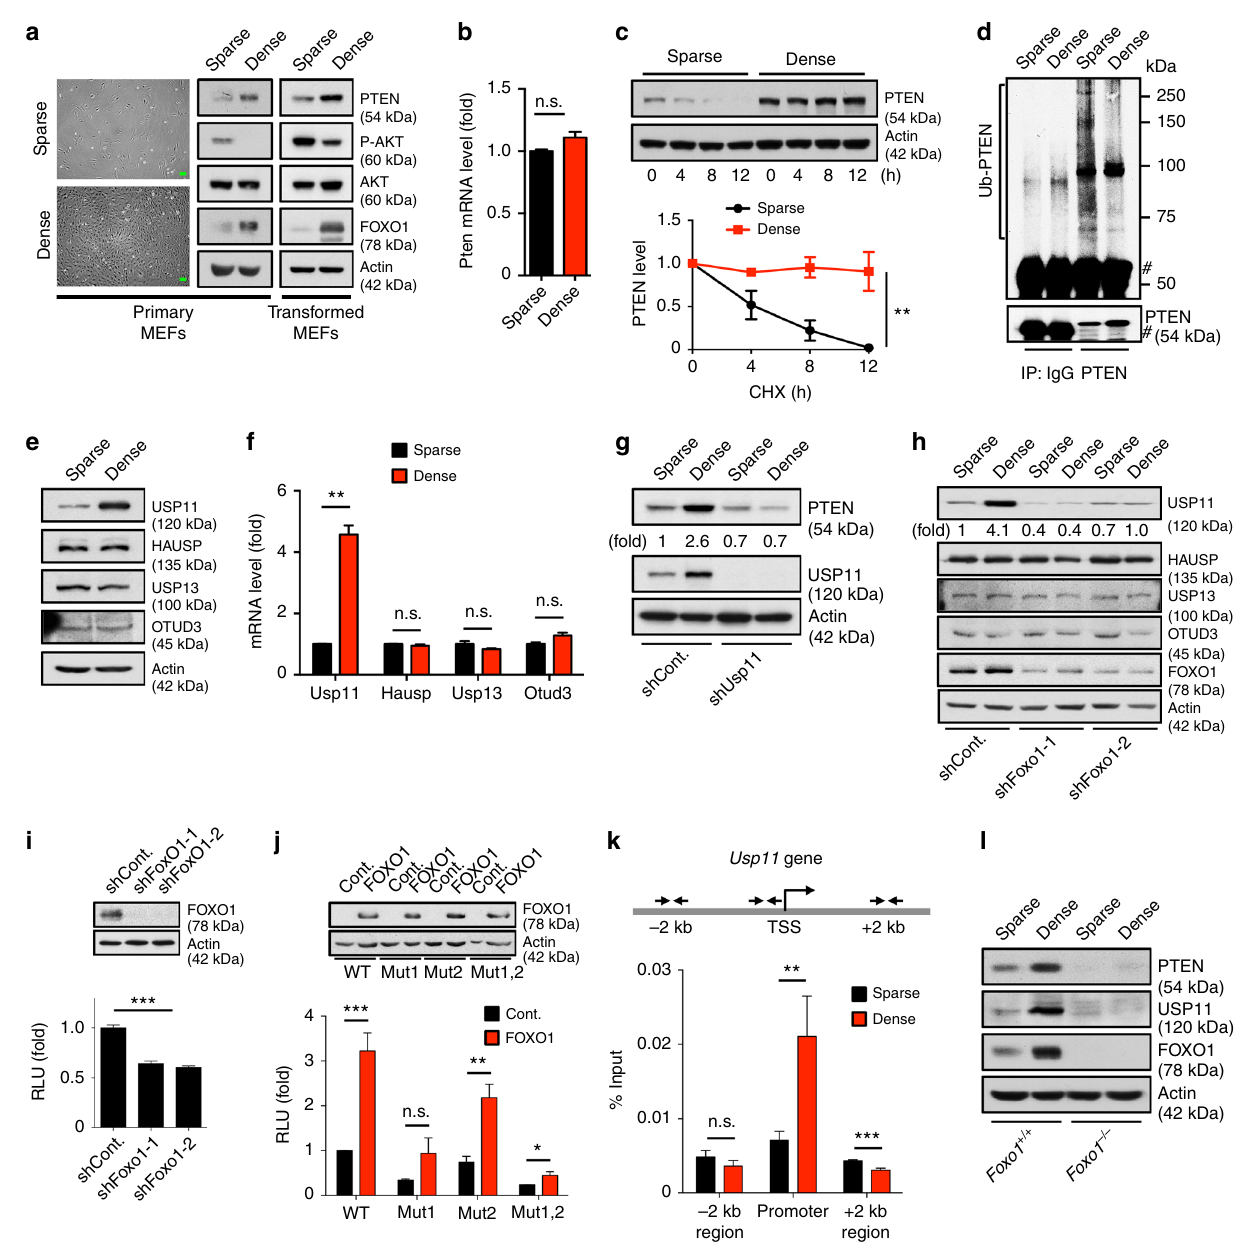
Fig. 6 USP11-mediated cell density-dependent PTEN regulation. a Representative images of sparse- and dense-con fl uent primary MEFs (left). Immunoblotting (IB) of sparse- and dense-con fl uent primary (middle) or transformed MEFs (right). Scale bars, 50 μ m. b Total RNAs from ( a ) were subjected to RT-qPCR. n = 3. c Lysates from sparse- and dense-con fl uent MEFs treated with cycloheximide (CHX, 100 μ g ml − 1 ) for the indicated times were subjected to IB (top). PTEN protein levels were quanti fi ed by normalizing to the intensity of the actin band (bottom). n = 3, p value was determined by ANOVA. d Lysates from sparse- and dense-con fl uent MEFs treated with 10 μ M MG132 for 4 h were immunoprecipitated (IP) with anti-PTEN, and the resulting IP were subjected to IB. # indicates the heavy chain of IgG. e, f Lysates and total RNAs from sparse- and dense-con fl uent MEFs were subjected to IB for the indicated proteins ( e ) and RT-qPCR ( f ). n = 3. g Lysates from sparse- and dense-con fl uent MEFs expressing Usp11 shRNA were subjected to IB. h Lysates from sparse- and dense-con fl uent MEFs expressing two independent Foxo1 shRNAs were subjected to IB. i Luciferase reporter analysis of the USP11 promoter in NIH-3T3 cells expressing Foxo1 shRNAs. n = 3. j Luciferase reporter analysis of two potent FOXO-binding site mutants (Mut) of the USP11 promoter in NIH-3T3 cells expressing FOXO1. n = 3. k Chromatin levels of FOXO1 at the proximal promoters of mouse Usp11 were compared between sparse- and dense-con fl uent MEFs by quantitative ChIP assays. Enrichment of FOXO1 was analyzed with respect to the input control (before IP) and normalized to IgG control. TSS, transcription start site. n = 3. l Lysates from sparse- and dense-con fl uent Foxo1 + / + and Foxo1 -/- MEFs were subjected to IB. Error bars represent ± SEM. p Value was determined by Student ’ s t test (n.s., non-signi fi cant; * p < 0.05, ** p < 0.01, *** p < 0.001). ChIP, chromatin immunoprecipitation; MEFs, mouse embryonic fi broblasts; RT-qPCR, quantitative reverse transcription